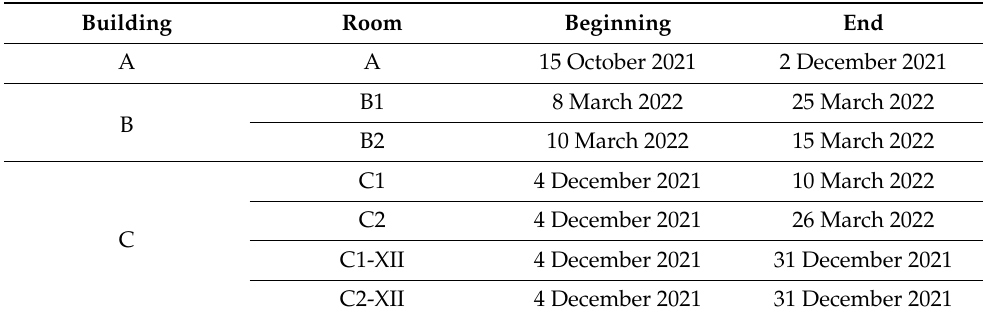
Table 4. Characteristics of the studied